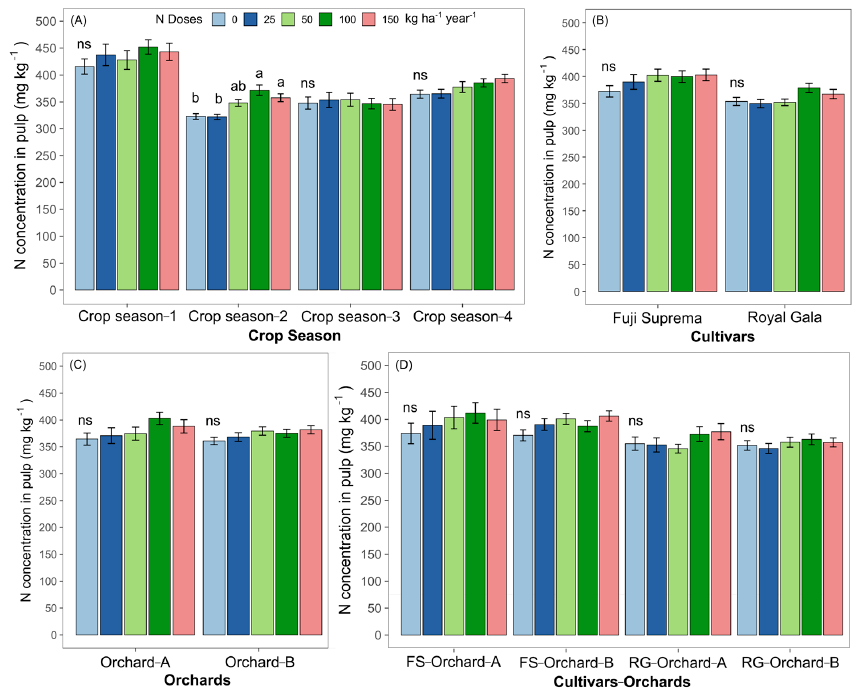
Figure 7. N concentrations in apple fruits (pulp) of two apple cultivars ( A – D ), grown in two orchards for different seasons and subjected to different N rates. Lowercase letters compare the means of N doses within the same factor (crop season, cultivar, orchard and cultivar—orchard) by Tukey’s test. Differences were considered significant when p value < 0.05; ns: non-significant at p ≥